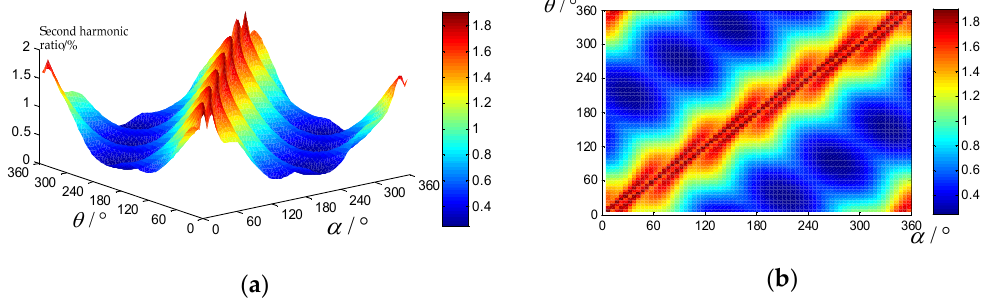
Figure 8. The distribution of the second harmonic ratio with the opening and closing angle: ( a ) front view; ( b ) top view. view; ( b ) top view.